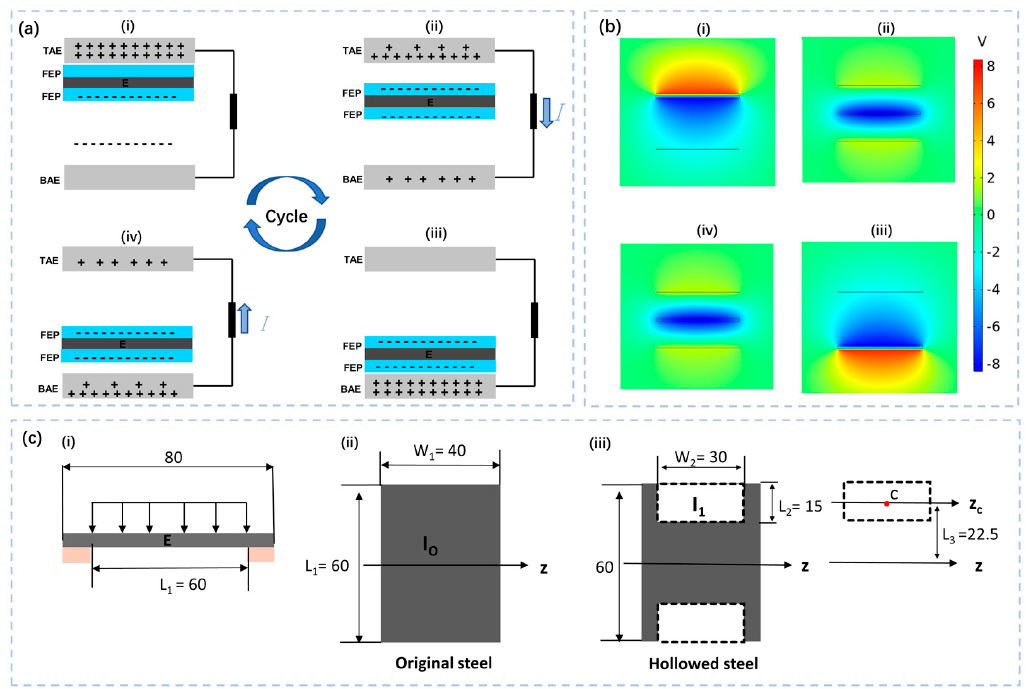
Figure 2. Working principle and simulation of the ES − TENG sensor. ( a ) Working principle of the ES − TENG; ( b ) simulation graphic of COMSOL Multiphysics; ( c ) force analysis diagram of elastic steel.